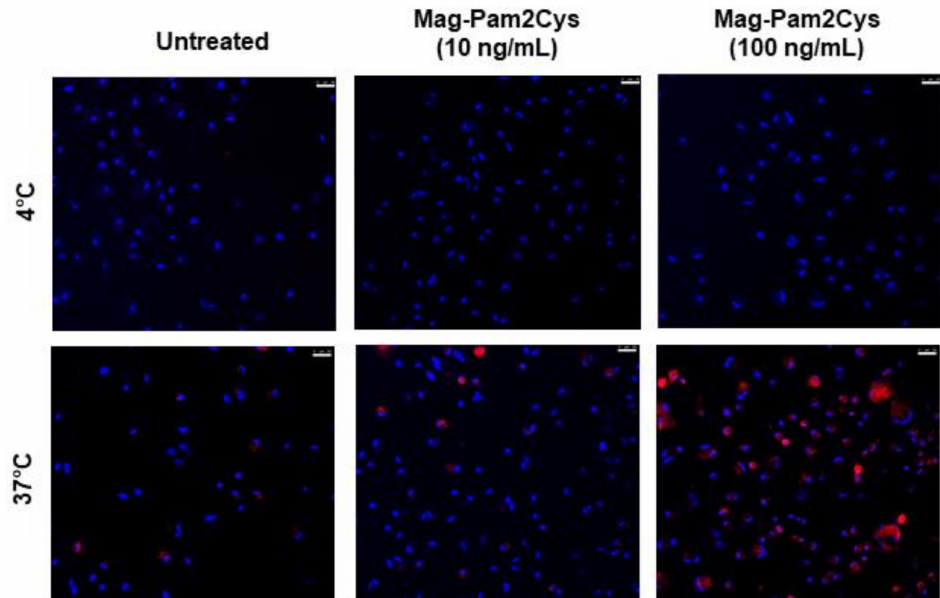
Figure 3. Mag-Pam2Cys’ impact on moM Φ phagocytotic ability. Porcine moM Φ were left untreated or stimulated with scalar doses of Mag-Pam2Cys (10 or 100 ng/mL). At 24 h post-stimulation, a phagocytosis assay was performed using pHrodoTM Red Zymosan A Bioparticles Conjugate (red). Cells were incubated with bioparticles for 2 h, at either 4 ◦ C (control) or 37 ◦ C. Then, nuclei were stained with Hoechst 33342 (blue), and confocal microscopy was performed using a 40 × magnifi- cation. Images of representative moM Φ , one from each condition (untreated, 10 or 100 ng/mL of Mag-Pam2Cys) are presented. Scale bar, 25 µ